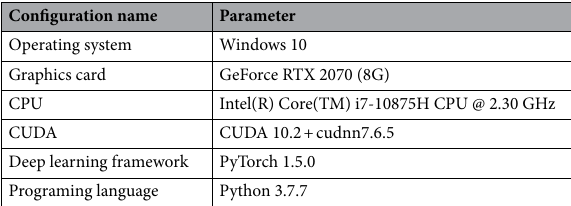
Table 1. Experimental environment configuration.